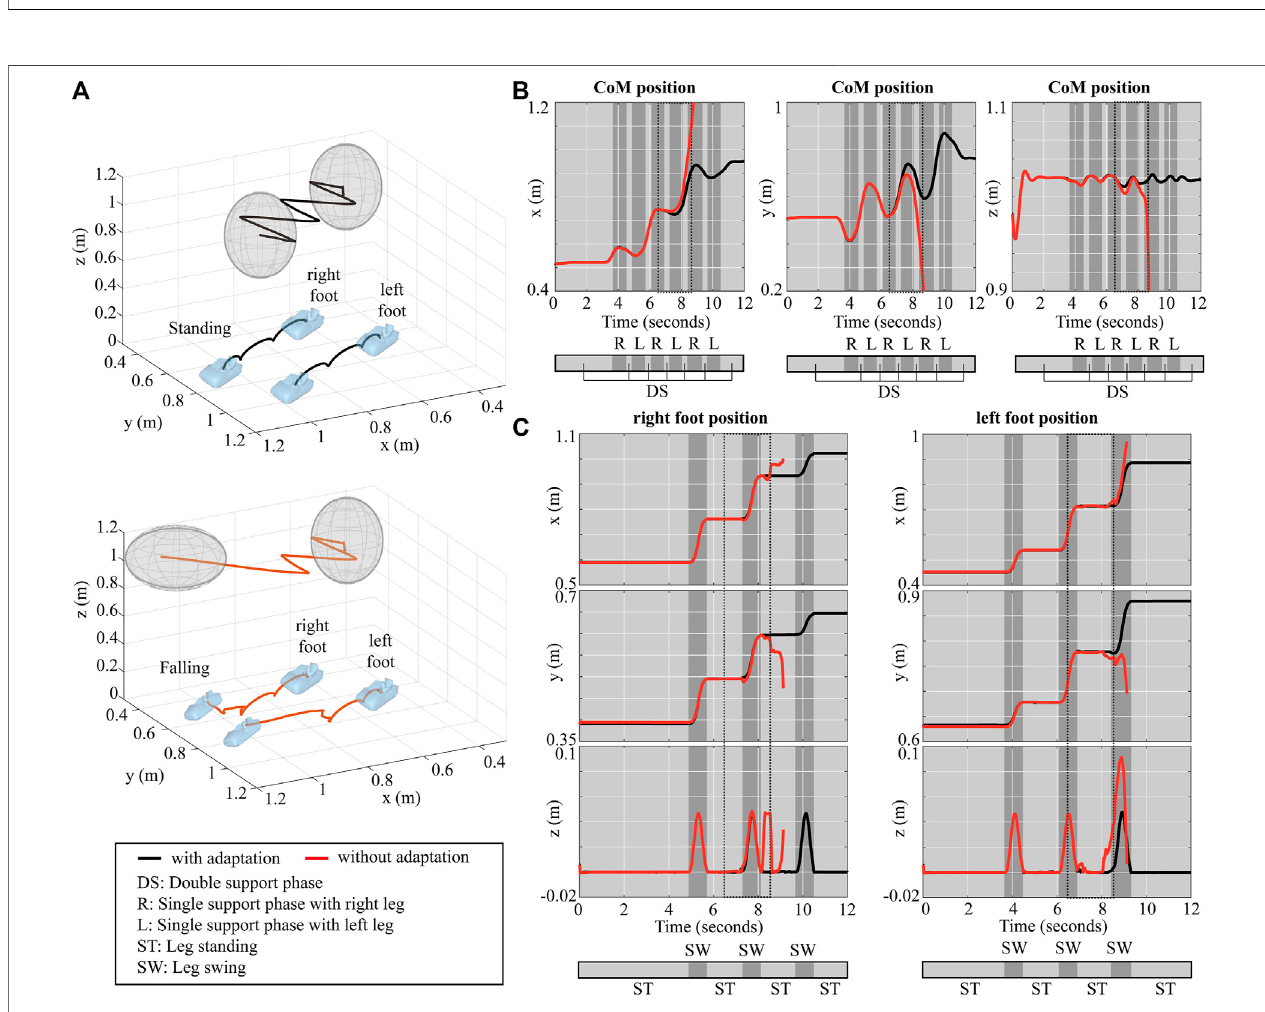
FIGURE11| Simulationresultsofwalkingwithanexternalforce: (A) positionsofCoMandfeetinCartesiancoordinate, (B) therobot ’ sCoMposition, (C) therobot ’ s feet positions.